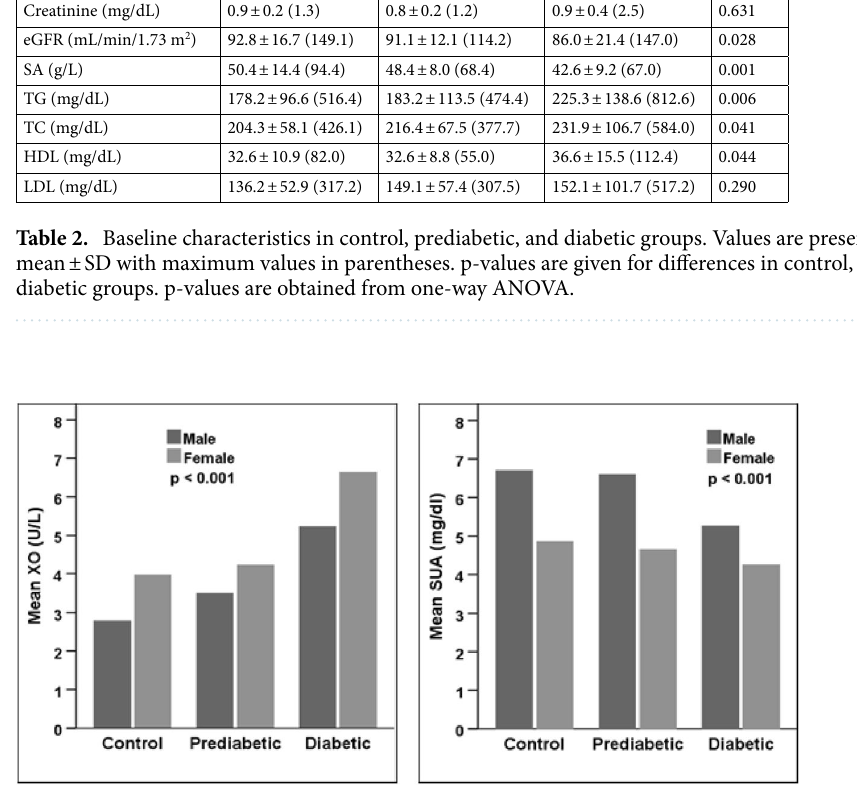
Figure 2. The mean of level XO and SUA in control, prediabetic, and diabetic groups. p-values are given for the mean differences of XO and SUA within the groups. p-values were derived from one-way